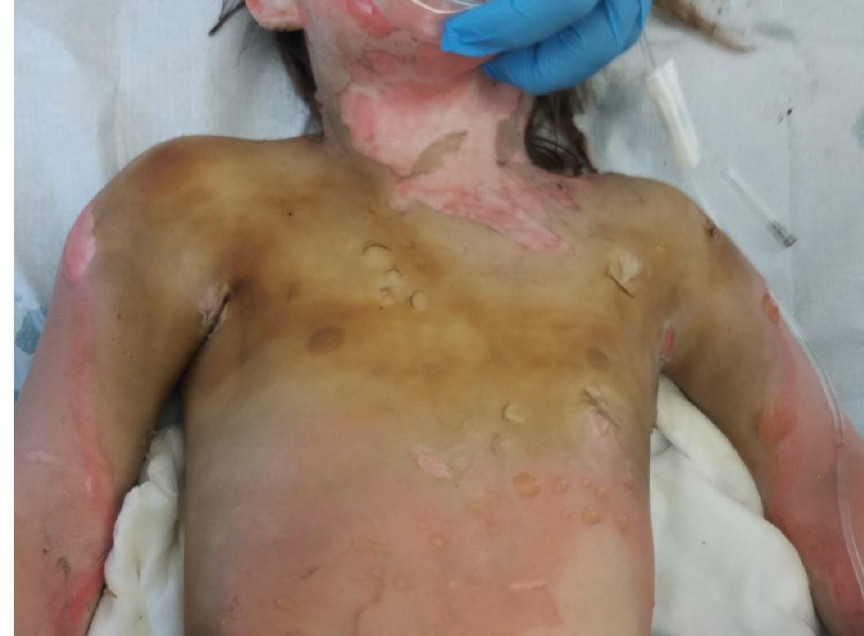
Figure 1. Burn on arrival.